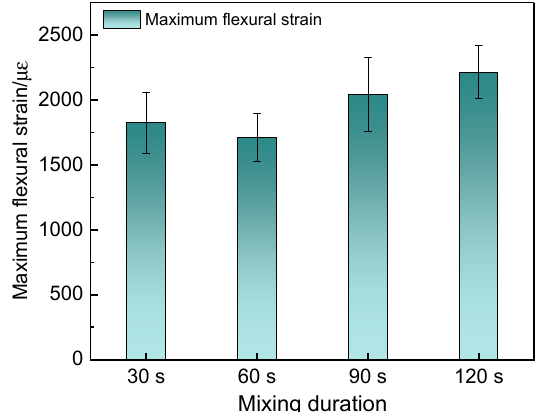
Figure 18. Low-temperature cracking test results.